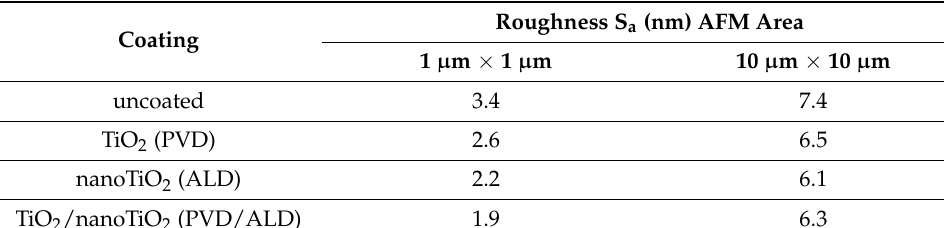
Table 1. The surface roughness of the investigated materials was obtained using an AFM microscope.